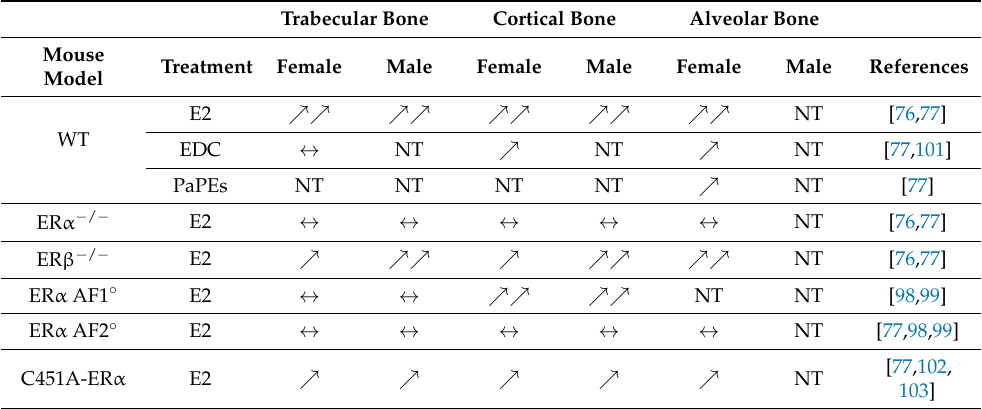
Table 2. Genetic and pharmacological approaches to study the roles of ERs and their subfunctions in bone tissue